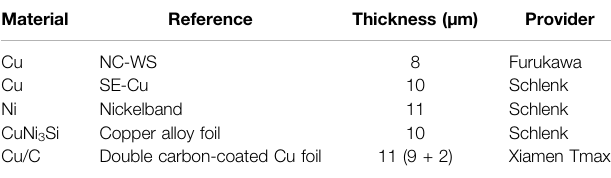
TABLE 1 | Selection of commercial current collectors.